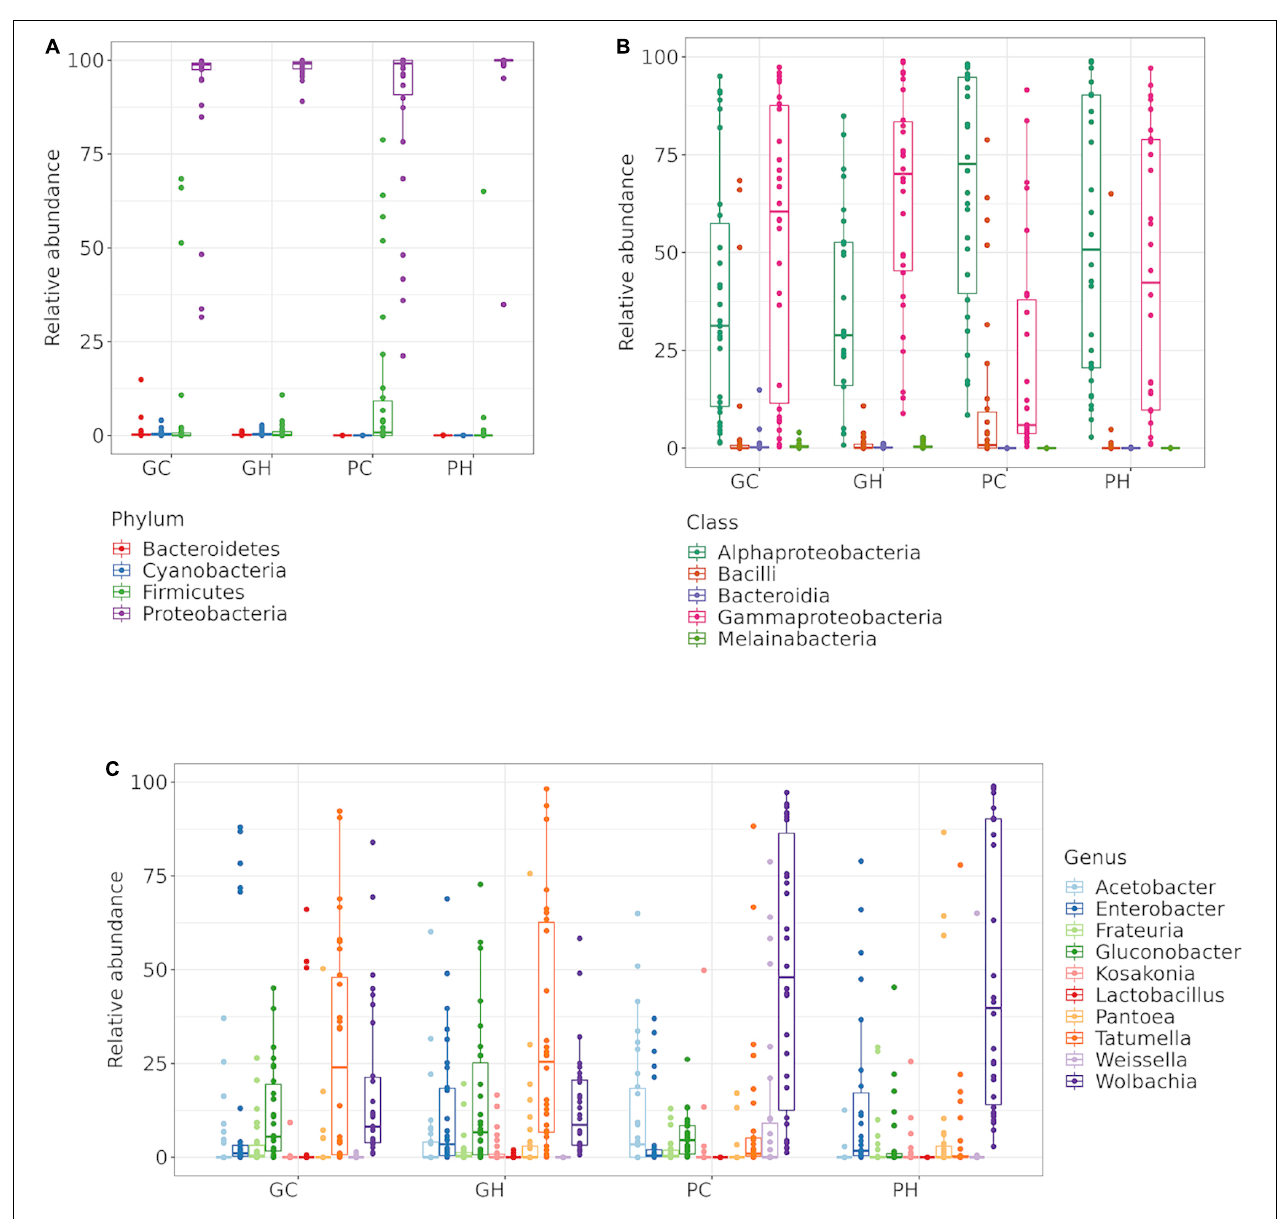
FIGURE 1 | Larval gut bacteria of Anastrepha fraterculus sp. 1. Relative abundance of the ten main OTUs identified. Taxonomic identification at: (A) Phylum, (B) Class and (C)